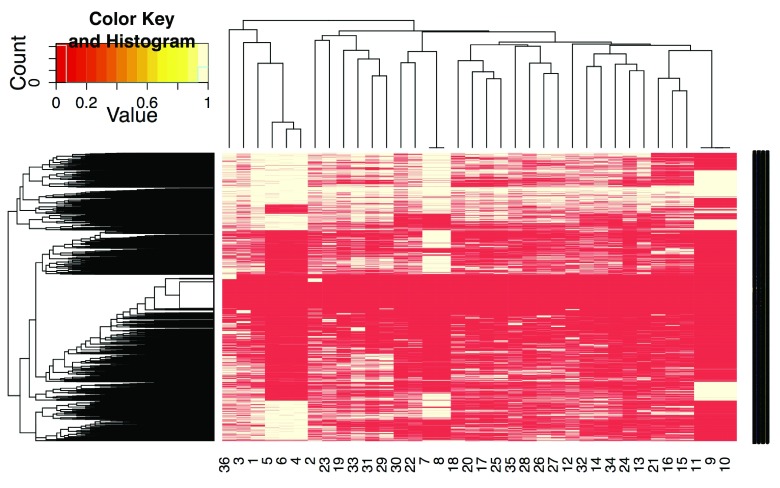
Clustering of MDRpred individual models.For each labeled sequence (rows) we assessed the presence (red cell) or absence (white cell) of a match to any of the 36 MDRpred regular expression models (columns). Hierarchical clustering was used to highlight relationships between models based on their patterns of matches. Dendrograms for sequences and models are shown. The patterns highlight seven groups of models that share a large number of predictions. Representative members from each of these clusters are shown in
Table 3.